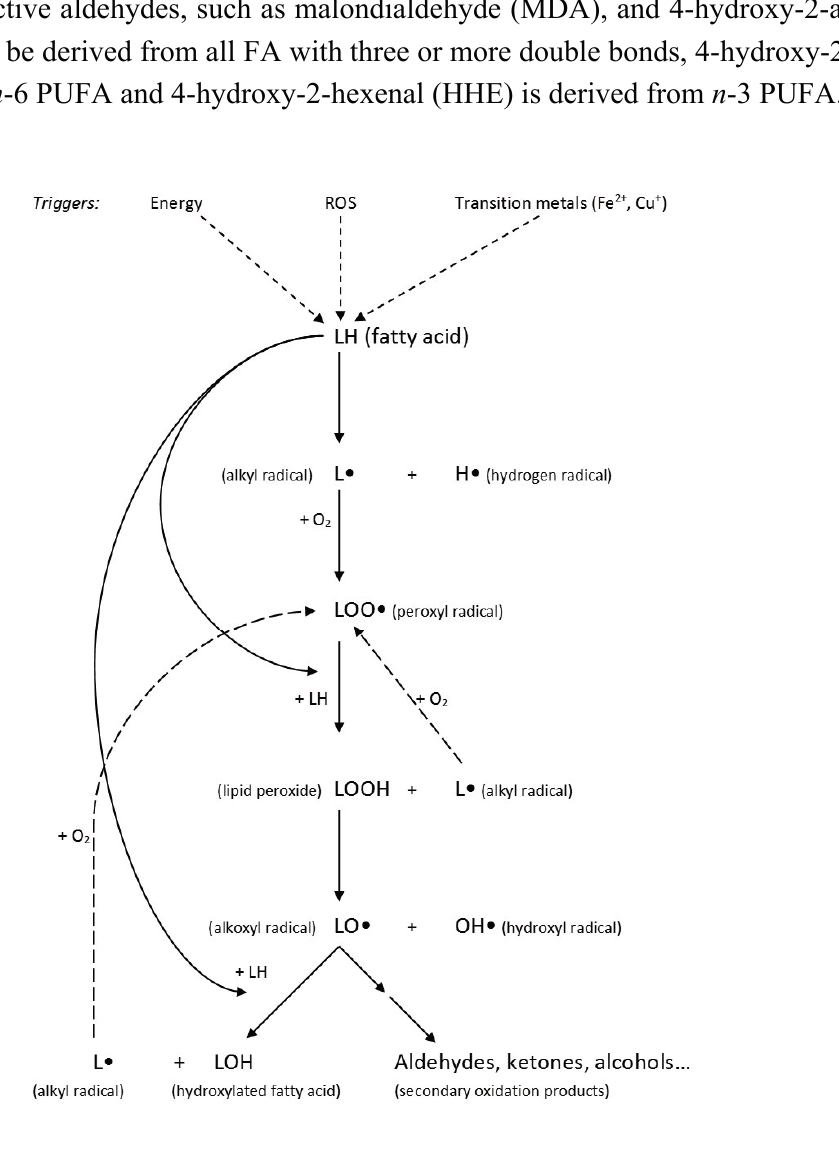
Figure 5. Illustration of the lipid peroxidation process. Triggered by energy, reactive oxygen species (ROS) and/or transition metals, an unstable hydrogen atom is abstracted from a fatty acid (LH), forming an alkyl radical (L•) and a hydrogen radical (H•). The alkyl radical reacts with oxygen, forming a peroxyl radical (LOO•) that further reacts with another fatty acid, forming a lipid peroxide (LOOH) and a new alkyl radical. The lipid peroxide is easily degraded into an alkoxyl radical (LO•) and a hydroxyl radical (OH•). The alkoxyl radical may either react with a new fatty acid, forming a hydroxylated fatty acid (LOH), or decompose into smaller, volatile compounds, such as aldehydes, ketones or